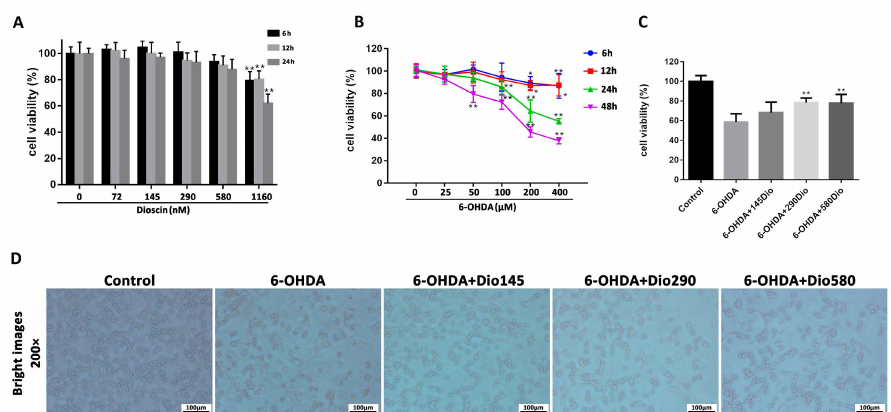
Figure 2. Dioscin alleviated 6-hydroxydopamine (6-OHDA)-induced injury and oxidative damage in PC-12 cells. ( A ) Cytotoxicity test of dioscin on PC12 cells. ( B ) Effect of 6-OHDA on PC12 cells. ** p < 0.01 and * p < 0.05, compared with the control group. ( C ) Protective effects of dioscin on 6-OHDA-induced cell injury. ( D ) Effects of dioscin on the morphological changes in PC12 cells. Data are expressed as mean ± SD ( n = 6). ** p < 0.01 compared with the 6-OHDA group.